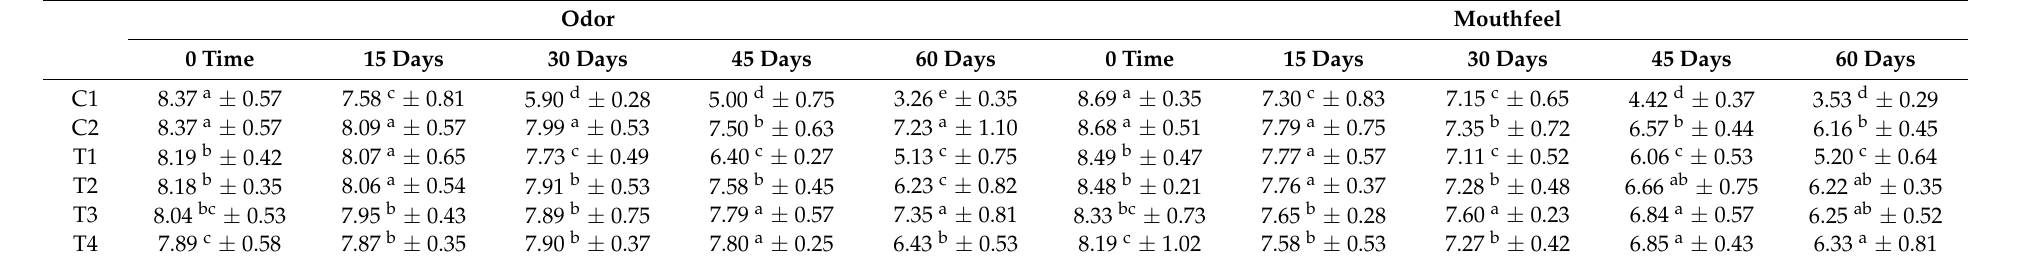
Table 11. Means of odor and mouthfeel values of mayonnaise samples enriched with RCFE during storage. Odor